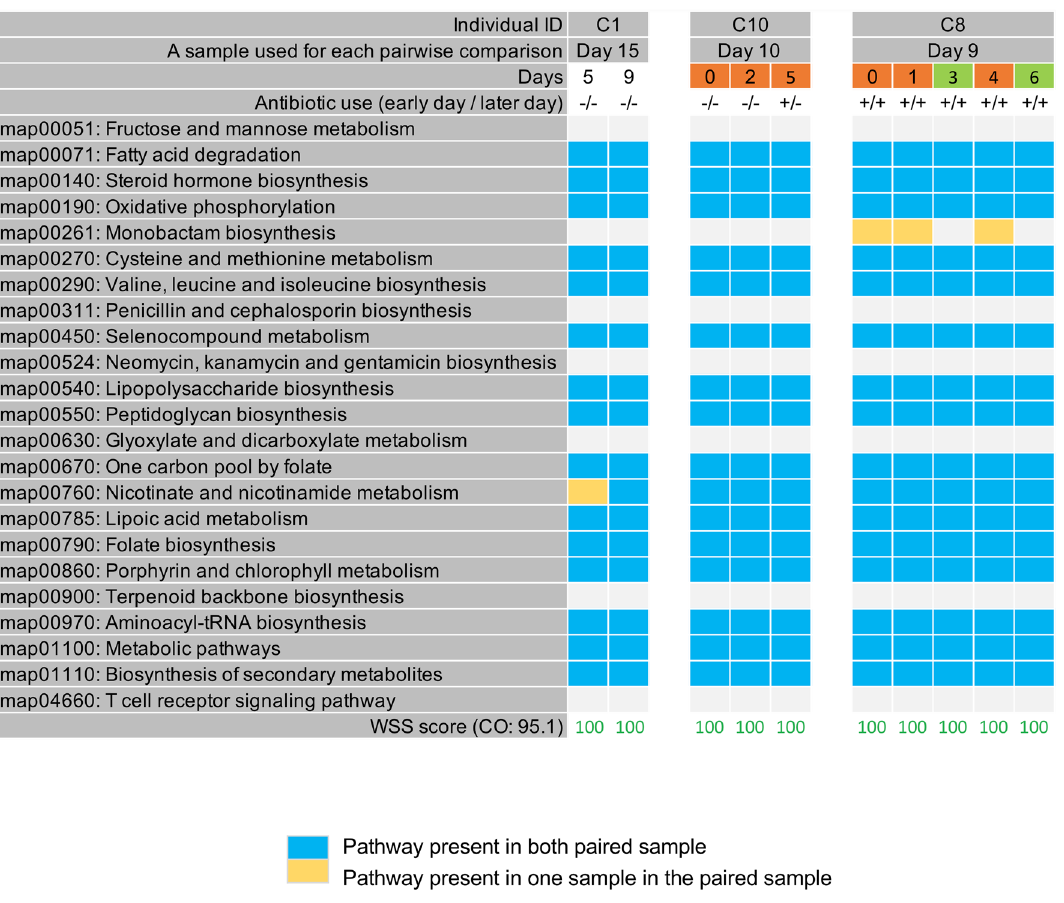
Figure 4. PKS results from hospitalized individuals with COVID-19. A total of 23 KEGG pathways were used to examine a pattern of presence/absence of KEGG metabolic pathways for B. vulgatus and the presence or absence of each KEGG pathway was observed by comparing each patient’s last day sample to every possible pair of the same patient’s samples. All patient samples were previously collected by Zuo et al. 17 . The shared PKS result per patient was grouped into different color boxes. Each column in the table indicates individual ID, a sample used for each pairwise comparison, and days. (Detailed information provided in Supplementary Table 2). 5 additional patients’ PKS results are shown in Supplementary Fig.